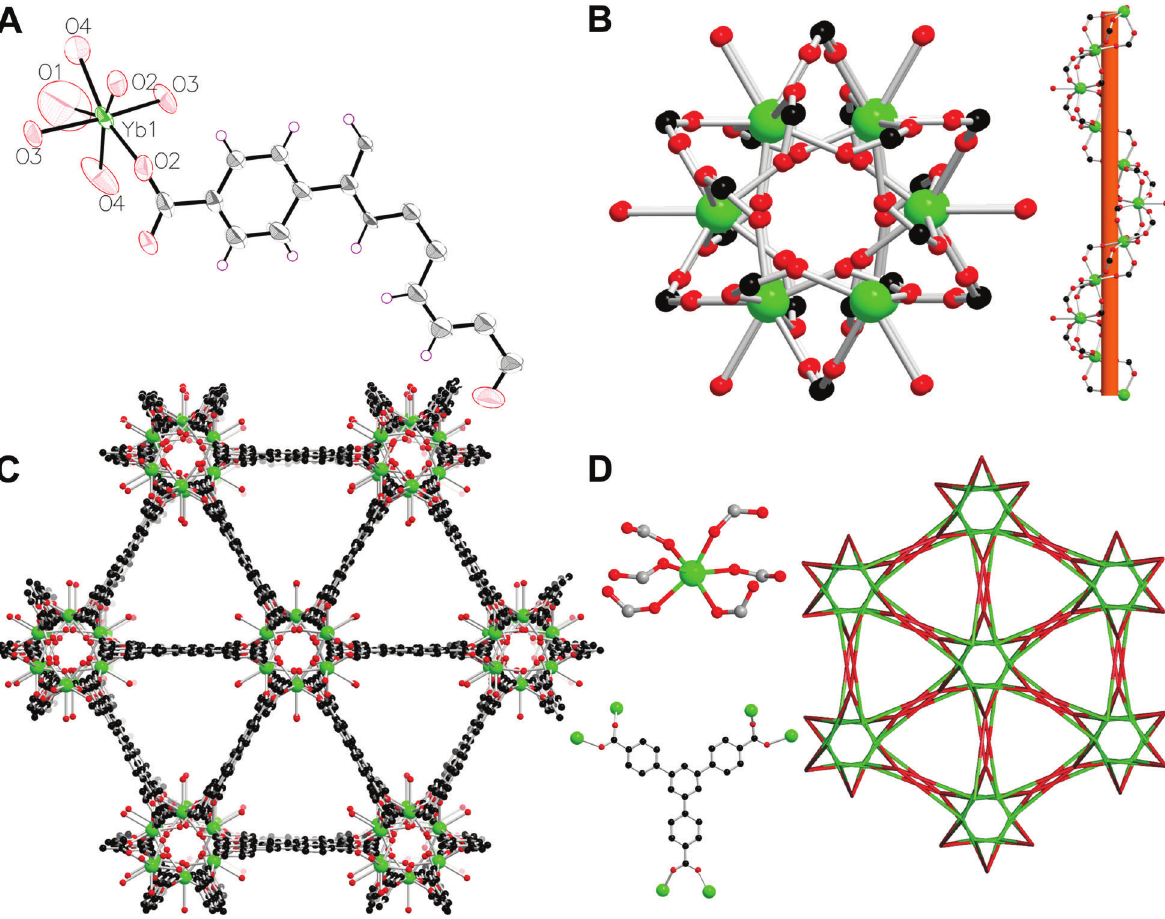
Figure 2. A , view of the asymmetric unit in compound 1 with 30% thermal ellipsoid level; B , view of 1D helical chain building units in 1 ; C , view of the 1D triangular channels in 1 ; D , (6,6)-connected topology for 1